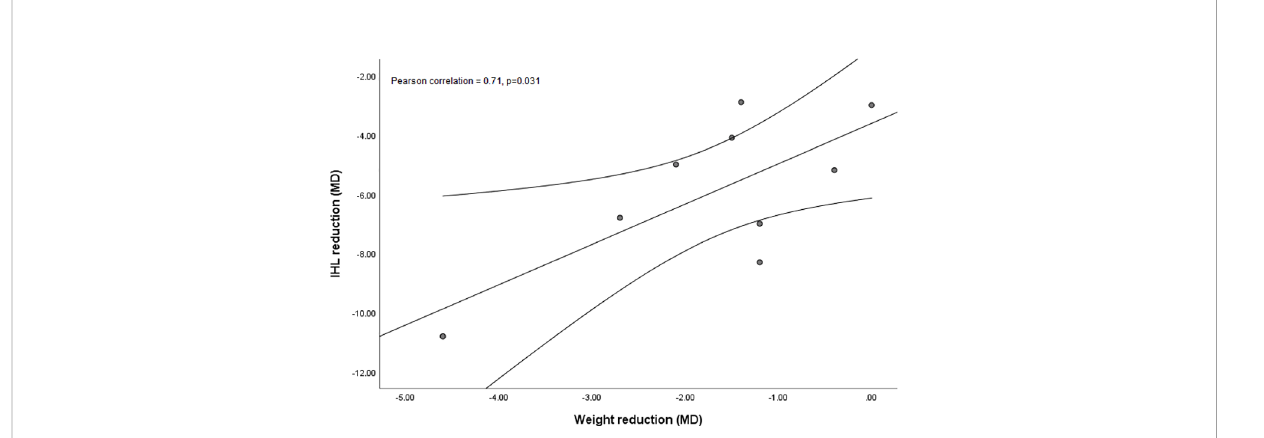
FIGURE 5 Simplescatterplotwithlinear fi t line and95% CI ofintrahepaticlipids (IHL, %) reduction mean difference(MD) against weight reduction(kg;MD) upon aerobic exercise (AE)including both modalities, high-intensity interval training(HIIT) and moderate-intensity continuous training (MICT) interventions.